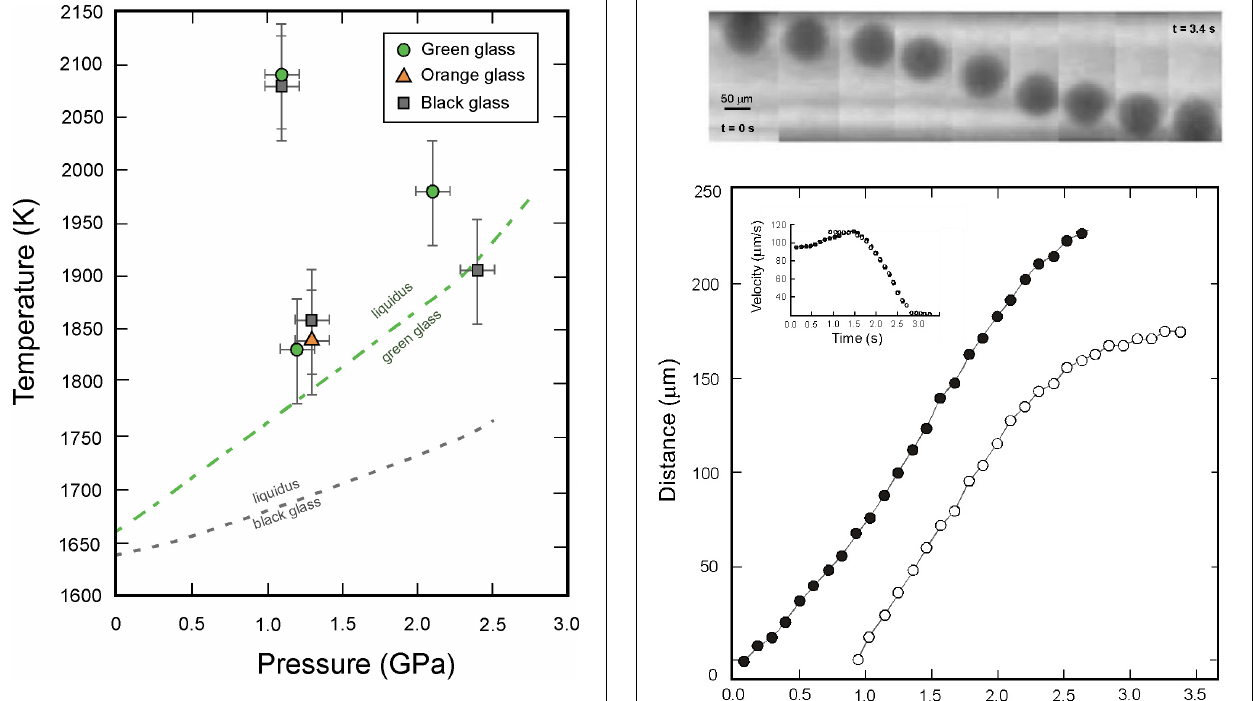
FIGURE 3 | Pressure-temperature conditions of the in situ viscosity measurements for the green (circles), orange (triangles) and black (squares) glasses, compared with experimentally determined liquidi for the green, orange and black glasses compositions (Wagner and Grove, 1997; Elkins-Tanton et al., 2003b; van Kan Parker et al., 2012). Error bars derive from errors in cross-calibration of P-T calibrants.